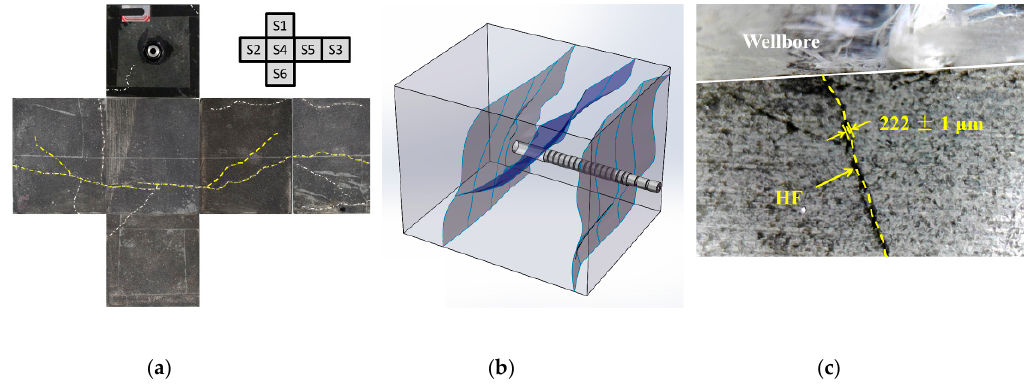
Figure 10. Fracture details of No. 1 specimen: ( a ) Distribution on the surface, ( b ) internal reconstruction, and ( c ) microscopy image. Figure 11. Fracture details of No. 2 specimen: ( a ) Distribution on the surface, ( b ) internal reconstruction, and ( c ) microscopy image.